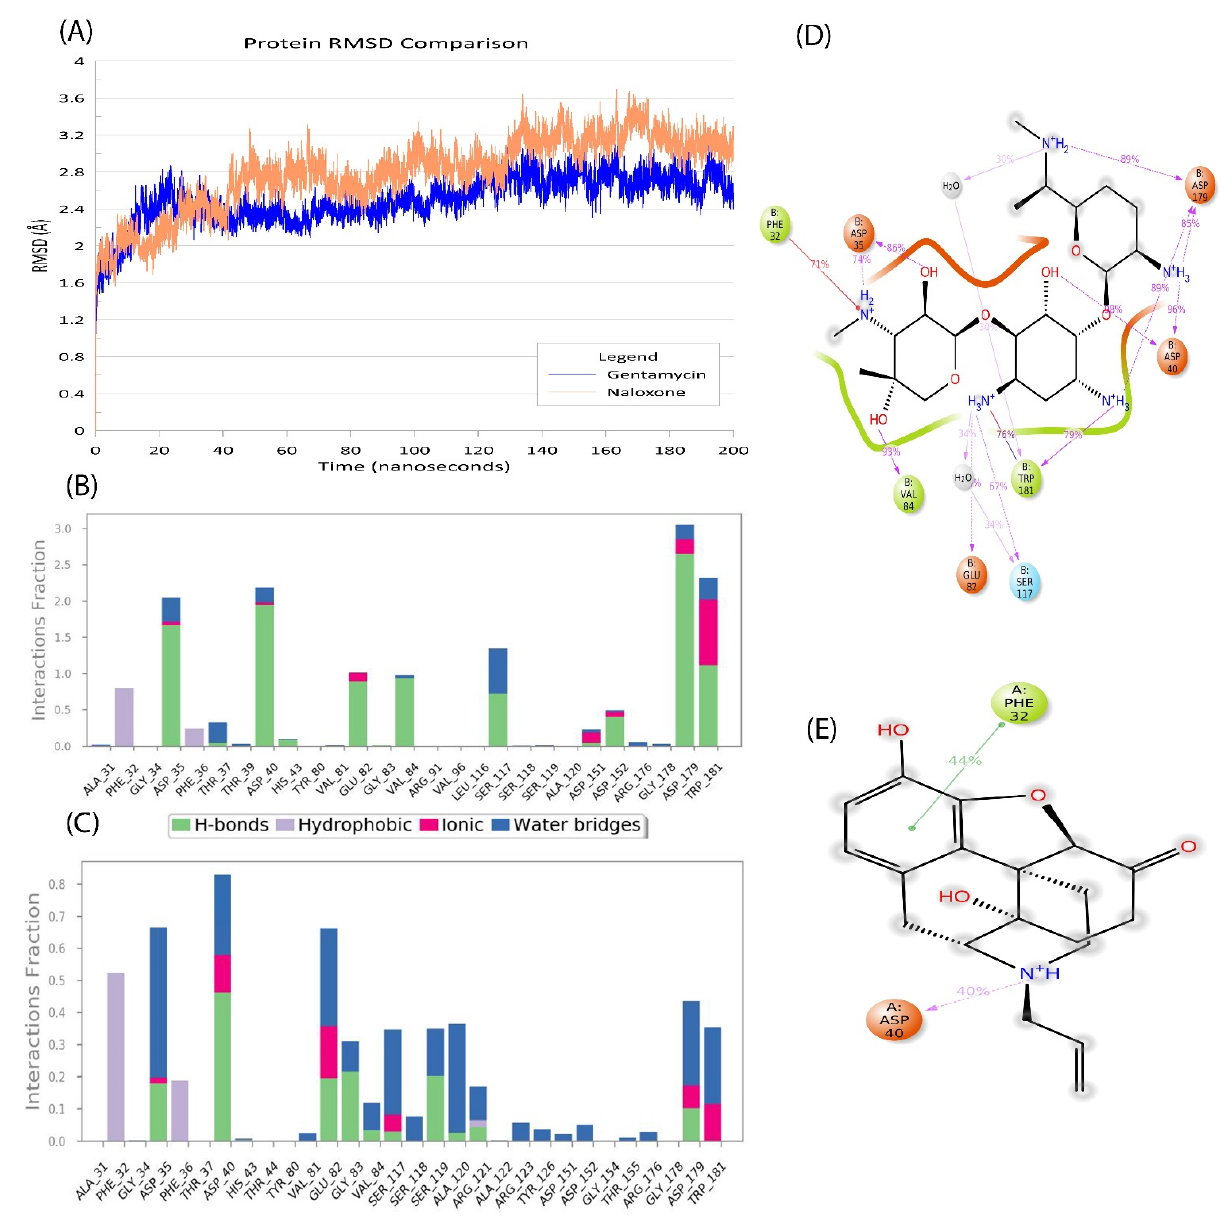
Figure 3. Molecular dynamics simulation profile for 200 ns. ( A ) A root mean square deviation (RMSD) profile of gentamicin (blue) and naloxone (light orange) has been plotted against time. The time of 200 ns is shown as 10,000 frames on the x-axis and RMSD change on the y-axis. ( B ) The protein–ligand contacts and type of interaction for gentamicin occurring over the simulation period are shown. ( C ) The protein–ligand contacts and type of interaction for naloxone occurring over the simulation period are shown. For both B and C, H-bonds are green, hydrophobic interactions are light purple, ionic interactions are pink, and water bridges are blue. The stacked bar charts are normalized over the course of the trajectory; for example, a value of 0.7 indicates that the specific interaction is maintained for 70% of the simulation time. As some protein residues may have several interactions of the same subtype with the ligand, values above 1.0 are feasible. ( D ) The 2D profile of gentamicin interactions after the simulation period with the residues in the binding sites ( E ) The 2D profile of naloxone interactions after the simulation period with the residues in the binding sites. For both D and E, the color codes signify the residues in orange are negatively charged, green are hydrophobic, and light blue are polar in nature. The interactions shown in pink are pi stacking and the ones in green are hydrogen bonds. The images were developed using Maestro v13.2 (Schrodinger